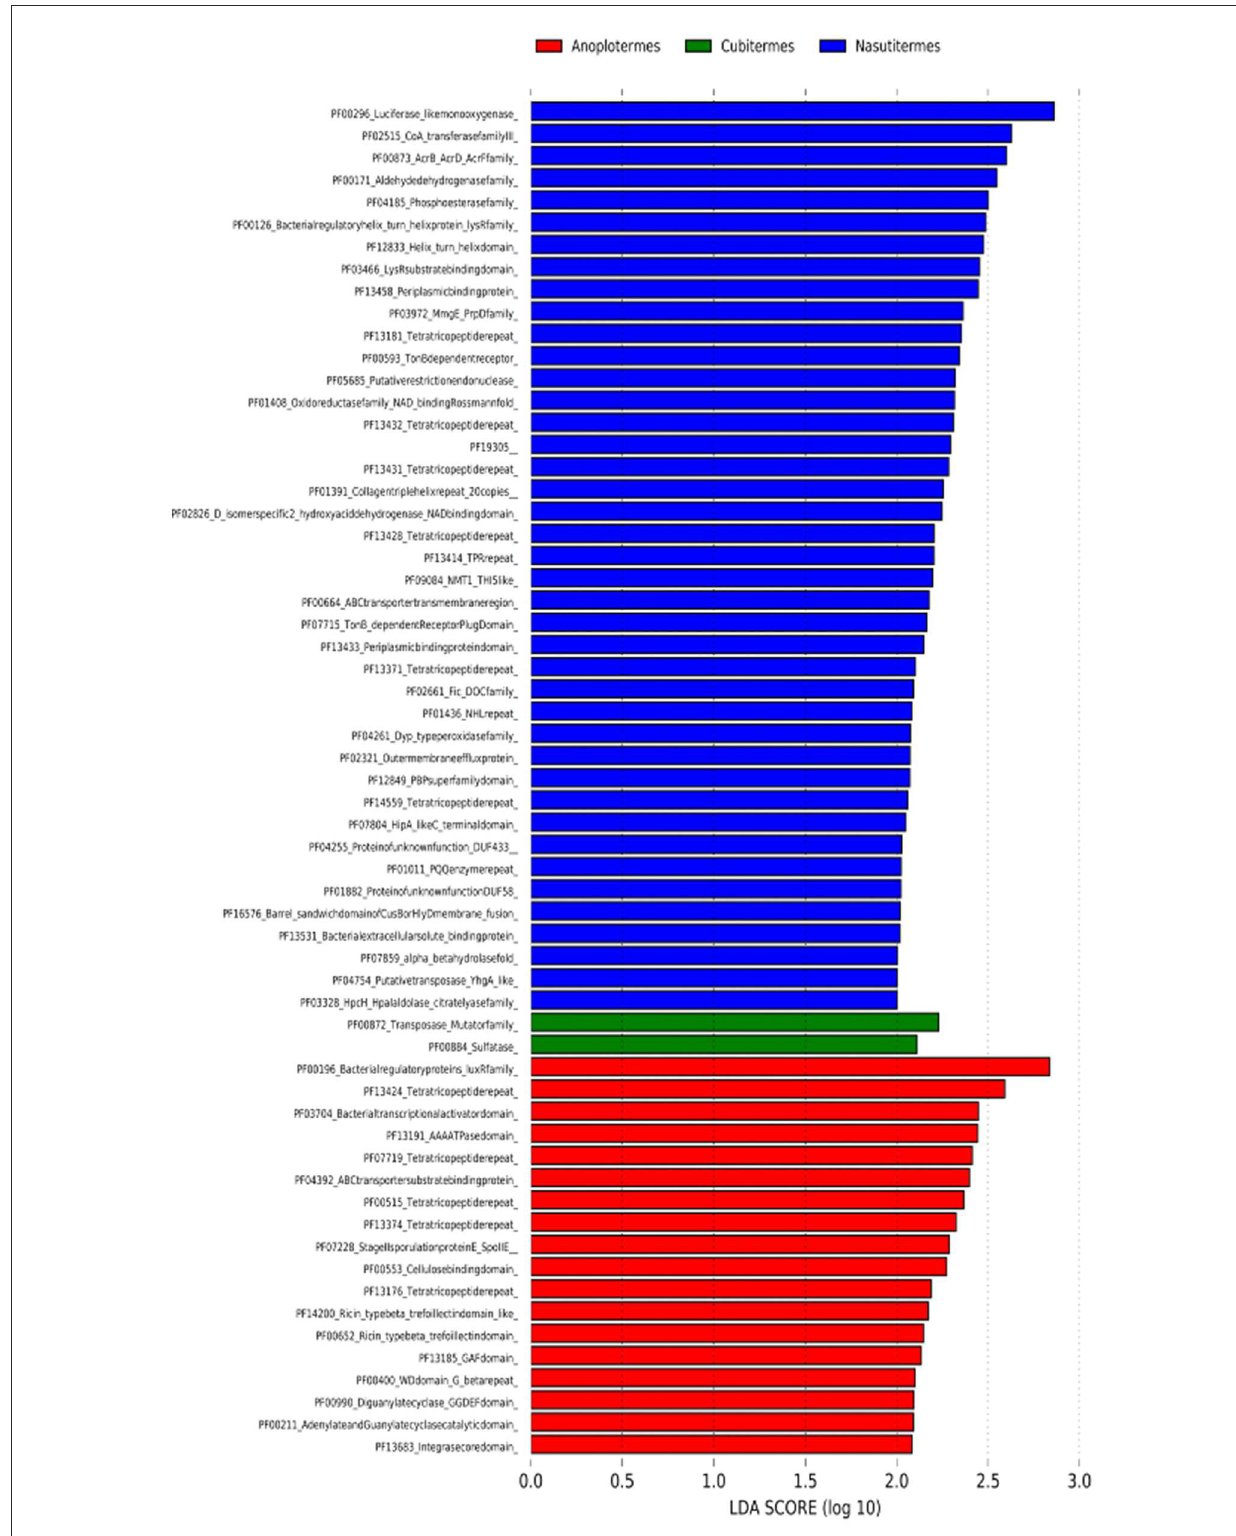
FIGURE8 LEfSe analysis for the contigs annotated in PFAM at LDA Score (log 10 ) for each category per genus.